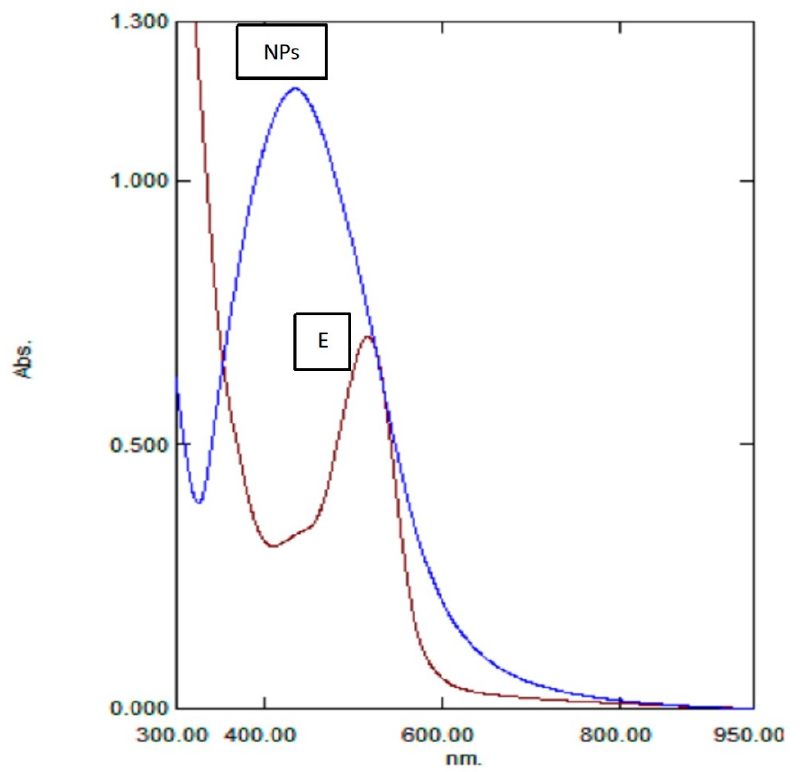
Figure 2. UV–Vis spectrum showing the LSPR peak of synthesised Rc-AgNPs at 435 nm. E-red currant aqueous extract, NPs-Rc-AgNPs.